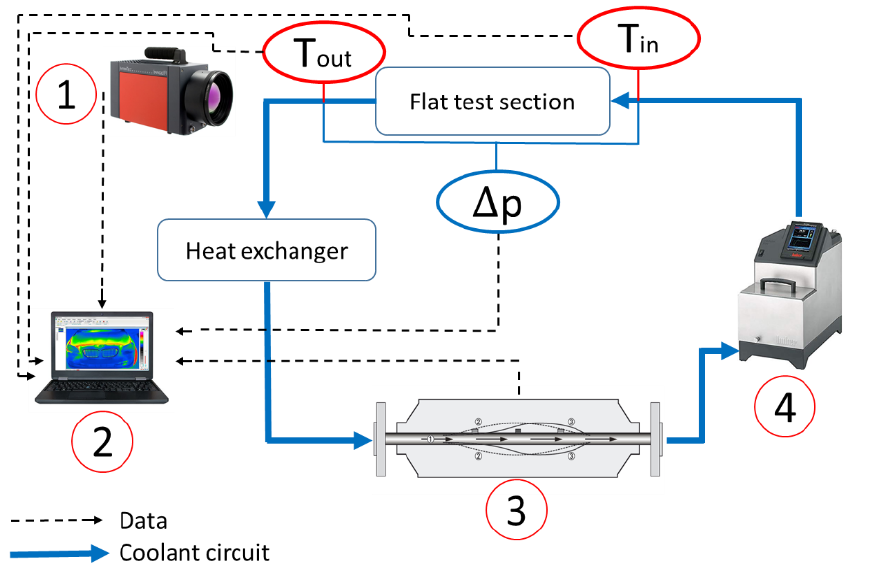
Figure 12. Schematic drawing of the test setup (1—thermographic imaging system, 2—data logging and control, 3—mass flow meter, 4—thermostat/cryostat).